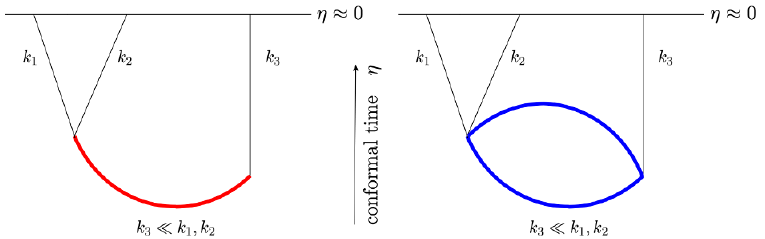
Figure 1 . From left to right: (a) Tree level exchange of neutral massive scalar (in red) between in(cid:13)atons (in black); (b) Loop level exchange of charged massive (cid:12)elds (in blue) between in(cid:13)atons (in black). The external lines are taken to end at the end of in(cid:13)ation, conformal time, (cid:17) (cid:25)